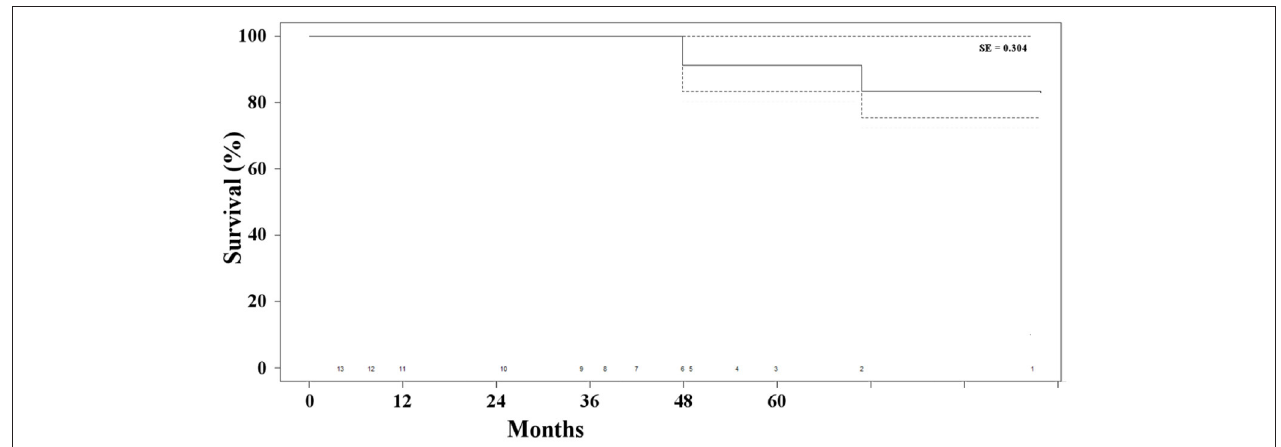
FIGURE 4 | Kaplan-Meier estimate of survival of the patients’ population.